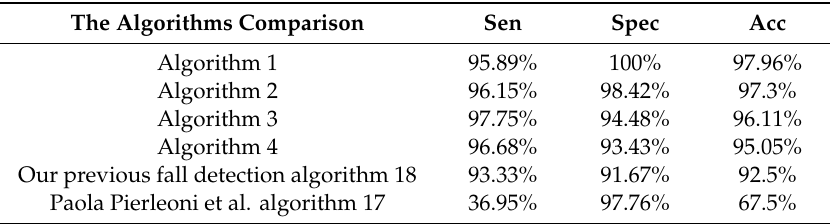
Table 9. The testing performance of our current proposed algorithms (fall detection and loss of physical performance detection), our previous fall detection algorithm, and Paola Pierleoni et al. algorithm on public